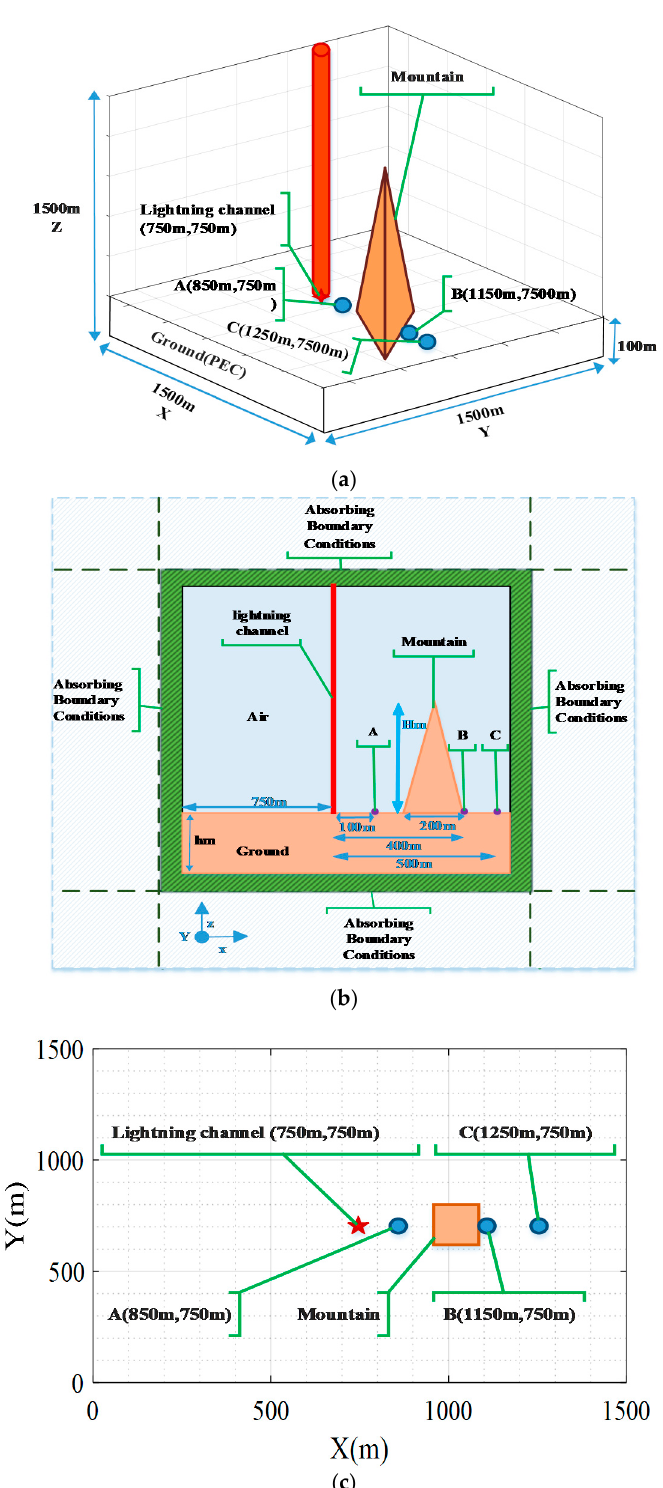
Figure 7. The simulation domain of the 3D-FDTD method and geometry for the lightning electromagnetic fields over mountainous terrain: (a) three-dimensional perspective, (b) side view, (c) top view.